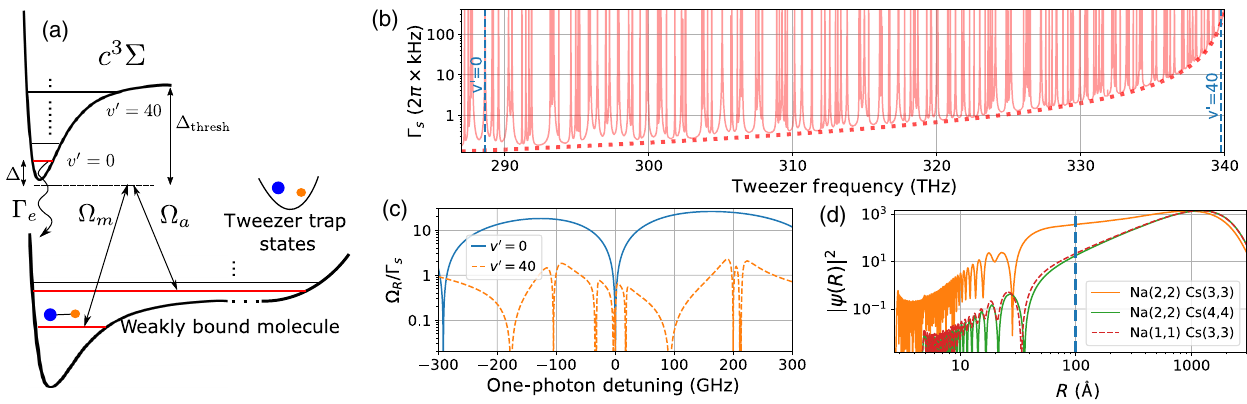
FIG. 1. Optical creation of single molecules from single atoms in an optical tweezer. (a) Schematic of the optical transition from an atom pair to a weakly bound molecule. The initial state is the relative motional ground state between the two atoms and the final state is the first molecular bound state. The transition is driven by a pair of laser frequencies whose difference ( < 1 GHz) matches the molecular binding energy. The lasers are detuned by Δ from an excited vibrational sublevel in the c 3 Σ þ ð Ω ¼ 1 Þ electronic state in order to reduce scattering during the transfer. (b) Calculation of the scattering rate versus laser frequency including all vibrational states of 8 excited- state potentials and the atomic continuum. The assumed excited-state linewidth for molecular lines is 50 MHz. The dotted red line shows the contribution from the near-threshold states, which approximately scales as 1 = Δ 2 . (c) Comparison between vibrational sublevels thresh of the intermediate excited state for the Raman transition. The lowest sublevel (blue line) has a larger optimum ratio of Raman Rabi frequency to scattering rate than the higher sublevel (orange line). (d) The large scattering length for Na(2, 2), Cs(3, 3) is associated with enhancement of the relative wave function at short internuclear distance ( R